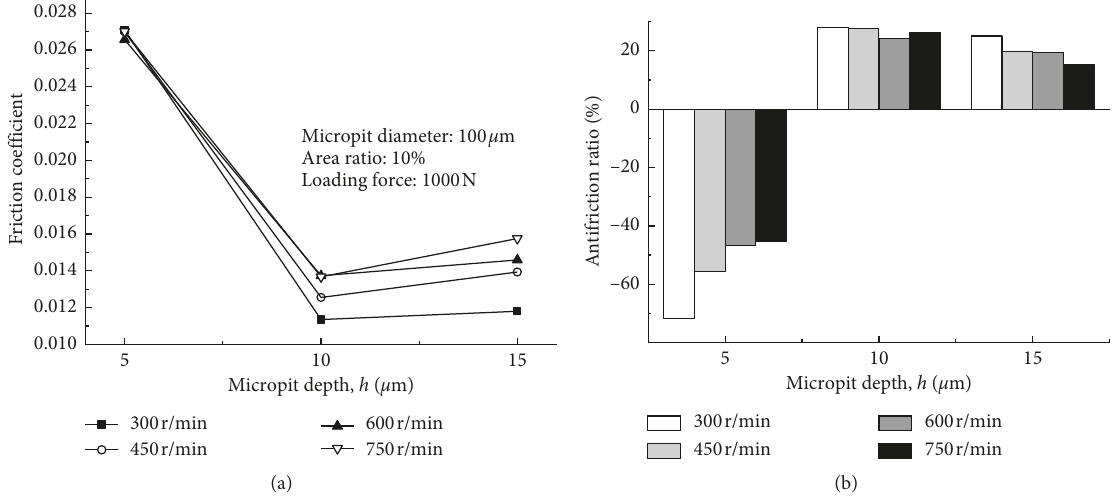
Figure 4: (a) Friction coefficient and (b) antifriction ratio when the value of the area ratio is 10%.